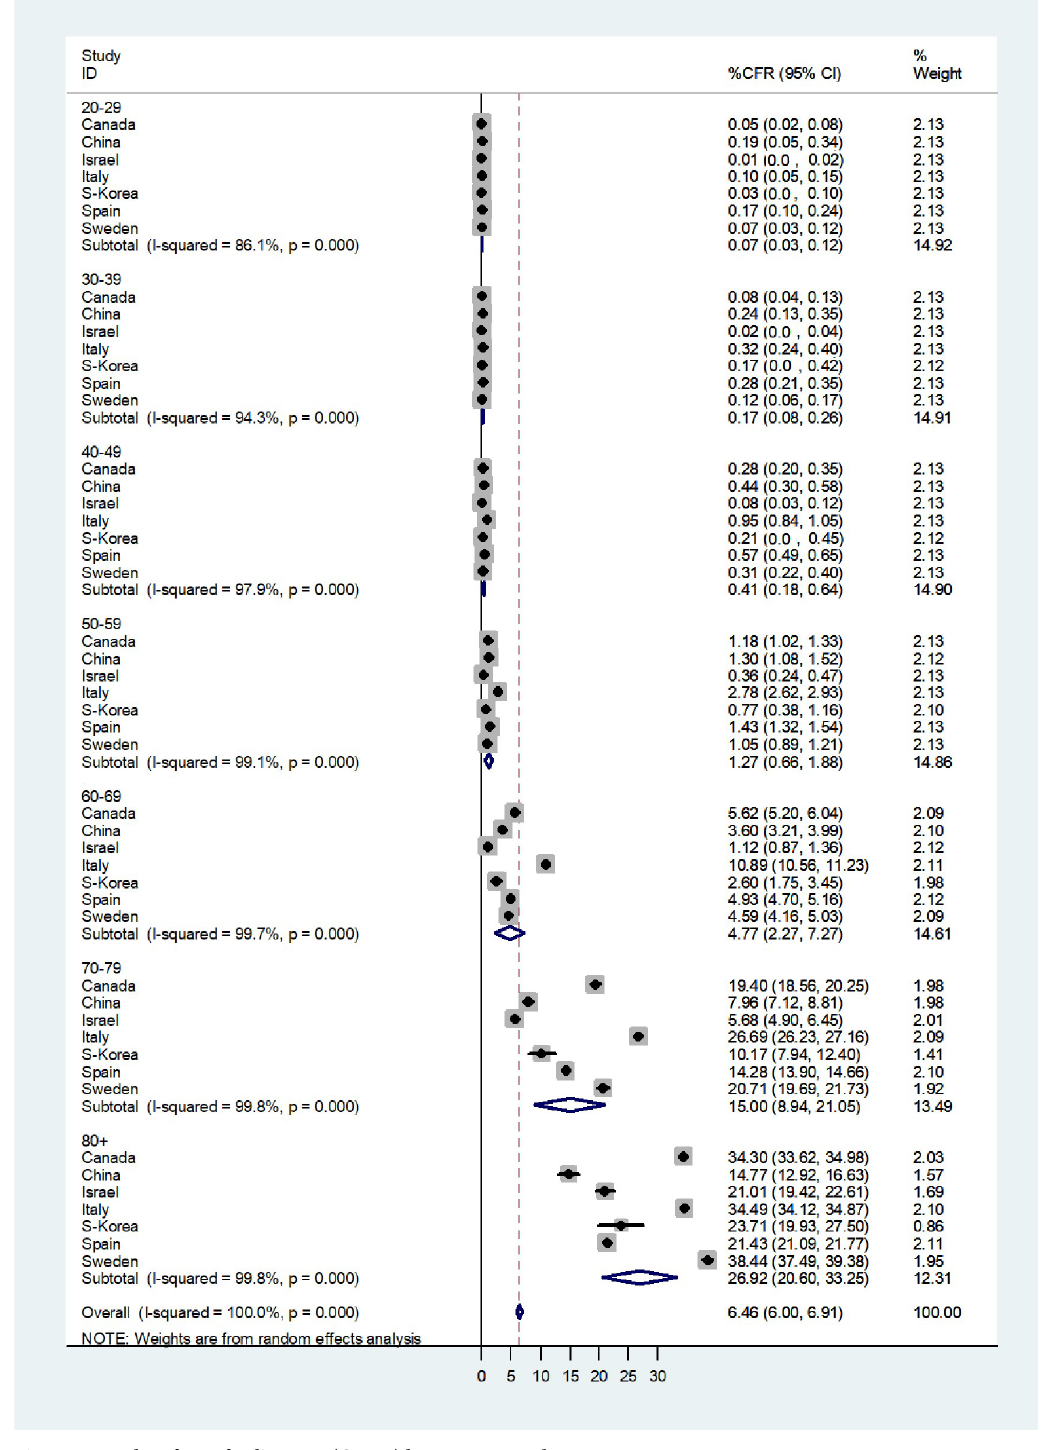
Fig 4. Forest plot of case-fatality rates (CFR %) by age group and country.